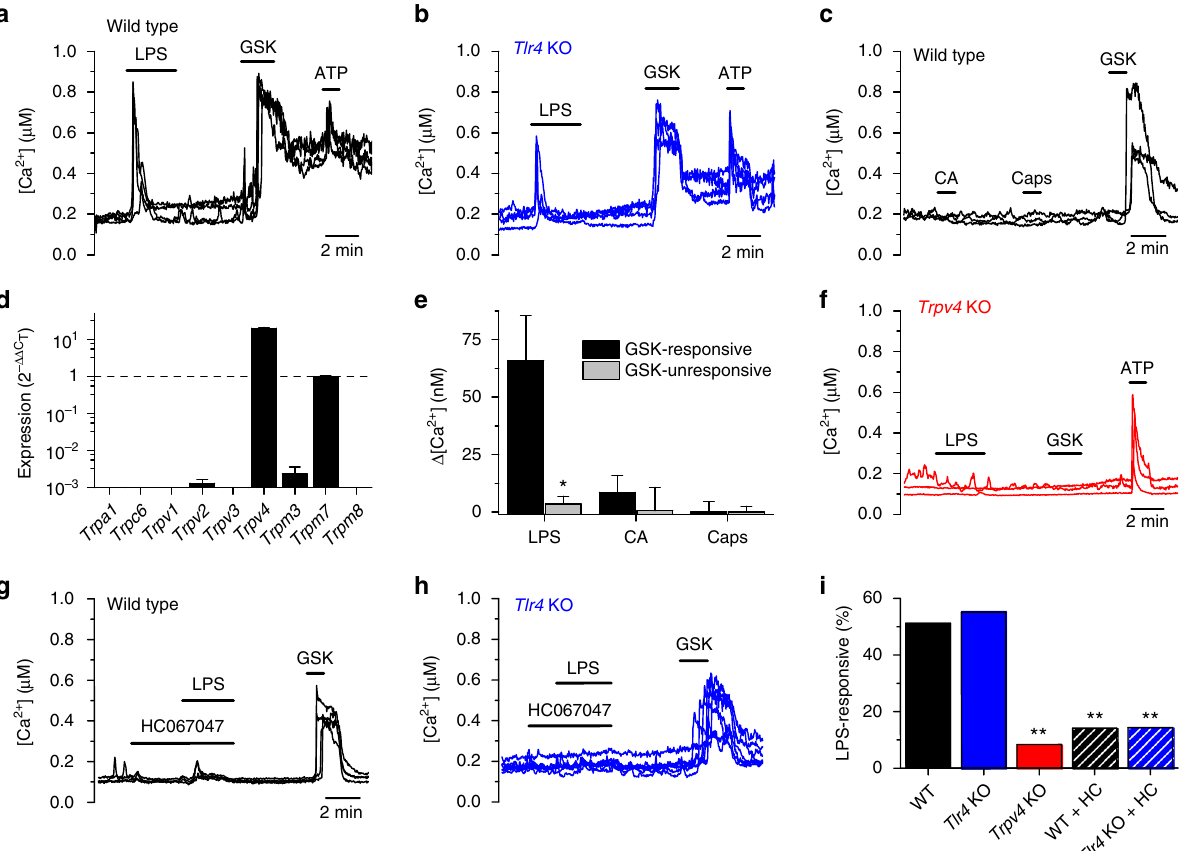
Fig. 1 LPS stimulates mTEC in a TLR4-independent and TRPV4-dependent manner. a , b Effects of LPS (20 µ g ml − 1 ), GSK1016790A (10 nM) and ATP (20 µ M) on the intracellular Ca 2+ concentration in mTEC primary cultures from wild type ( a ) or Tlr4 KO ( b ). c Traces of intracellular Ca 2+ concentration showing the lack of response of mTEC to the TRPA1 agonist cinnamaldehyde (CA, 300 μ M) and to the TRPV1 agonist capsaicin (1 μ M). d mRNA expression pro fi le of several TRP genes. Data is shown as 2 − ΔΔ CT relative to Trpm7 expression. e Average amplitudes of intracellular Ca 2+ responses to LPS (20 μ g ml − 1 ), the TRPA1 agonist cinnamaldehyde (CA, 300 μ M), and the TRPV1 agonist capsaicin (Caps, 1 μ M) in cells responsive or irresponsive to 10 nM GSK1016790A. n = 73; * P < 0.05, Mann – Whitney U test. f Effects of LPS (20 µ g ml − 1 ), GSK1016790A (10 nM) and ATP (20 µ M) on the intracellular Ca 2+ concentration in mTEC primary cultured from Trpv4 KO mice. g , h Traces of intracellular Ca 2+ concentration in wild type ( g ) and Tlr4 KO ( h ) cells exposed to 10 µ M HC067047, 20 µ g ml − 1 LPS and later on to 10 nM GSK1016790A (GSK). i Percentage of mTEC responding to LPS ( n > 46). ** P < 0.01, Fisher ’ s exact test. HC, HC067047 (10 µ